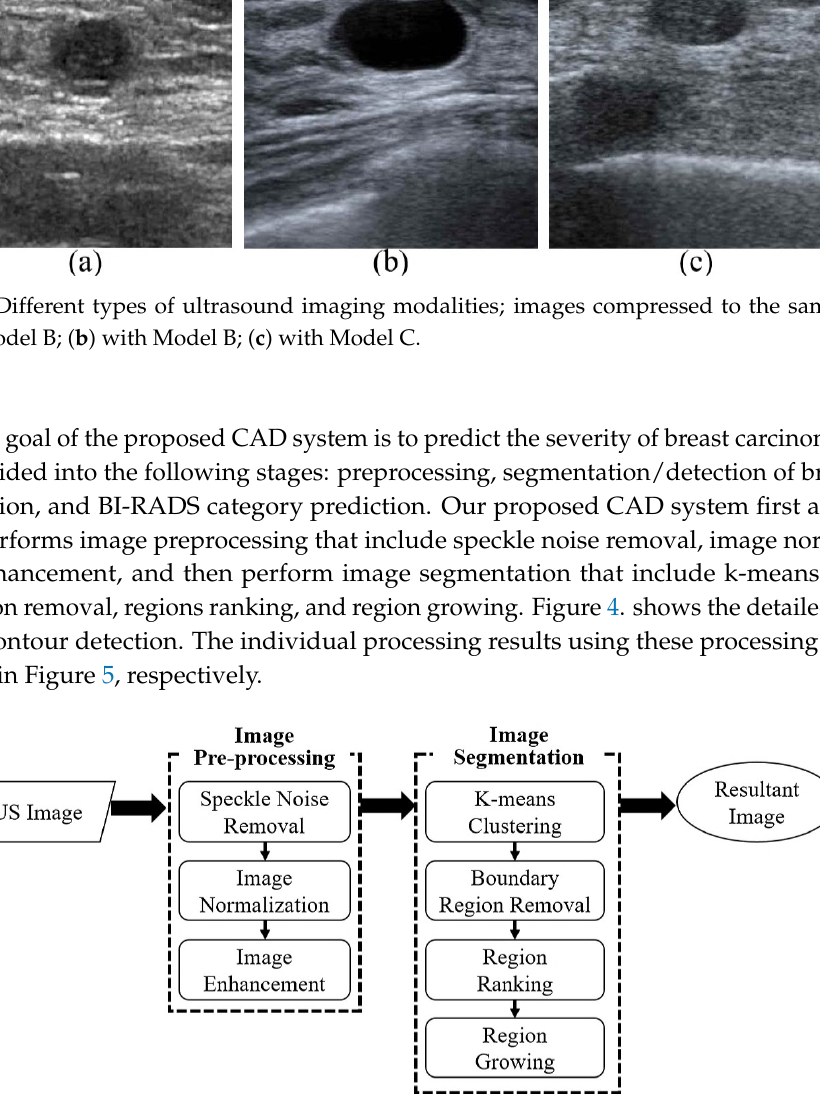
Figure 4. The flowchart for the contour detection of breast